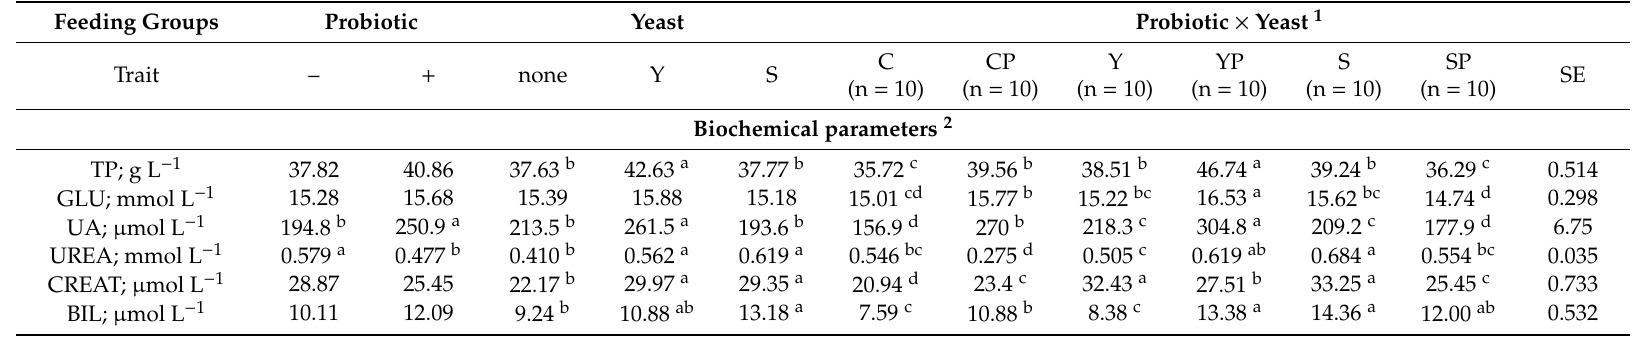
Table 3. Results of statistical analysis of biochemical blood plasma parameters in turkey hens. Feeding